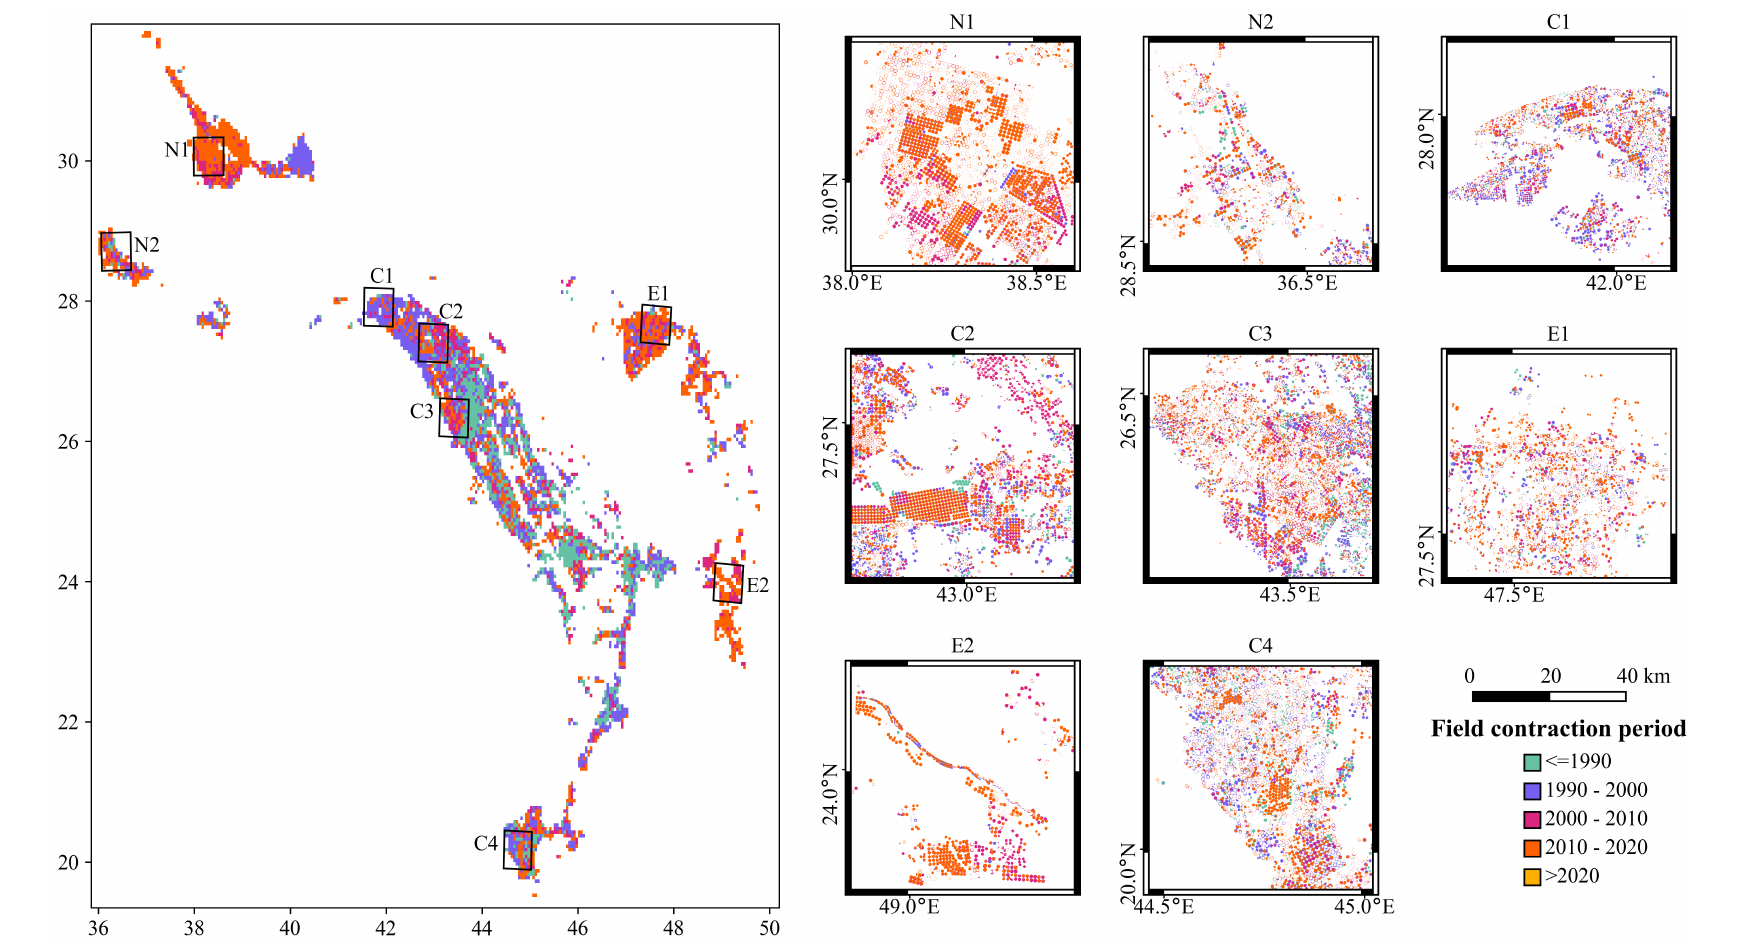
Figure 12. Center-pivot field contraction map. The map was generated by identifying the year the framework last detected each pixel within a field (before 2021). The national-scale map ( left ) was resampled to 0.05 ◦ resolution using the mode resampling method for visualization purposes, while the regional maps ( right ) show the data at 30 m resolution, with the scale bar shown in the lower right